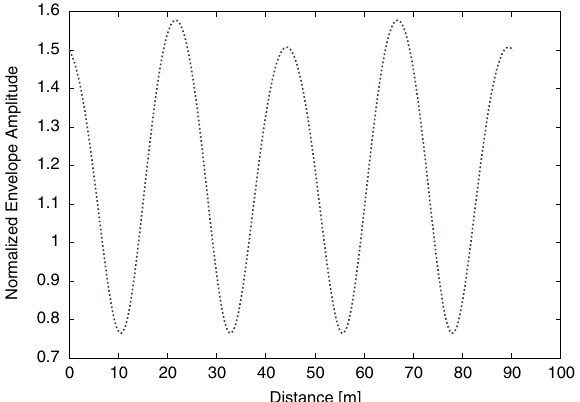
FIG. 2. (Color) The maximum normalized envelope amplitude versus the vertical space charge tune shift normalized to the fractional vertical bare tune (0.19). The solid (red) and dashed (blue) lines represent the predictions of Sacherer’s model for the horizontal and vertical planes, respectively, and the red (cid:1) ’s and blue (cid:13) ’s represent the horizontal (with (cid:2) p=p (cid:9) 0 ) and vertical predictions, respectively, of the particle core model implemented in the ACCSIM tracking code.